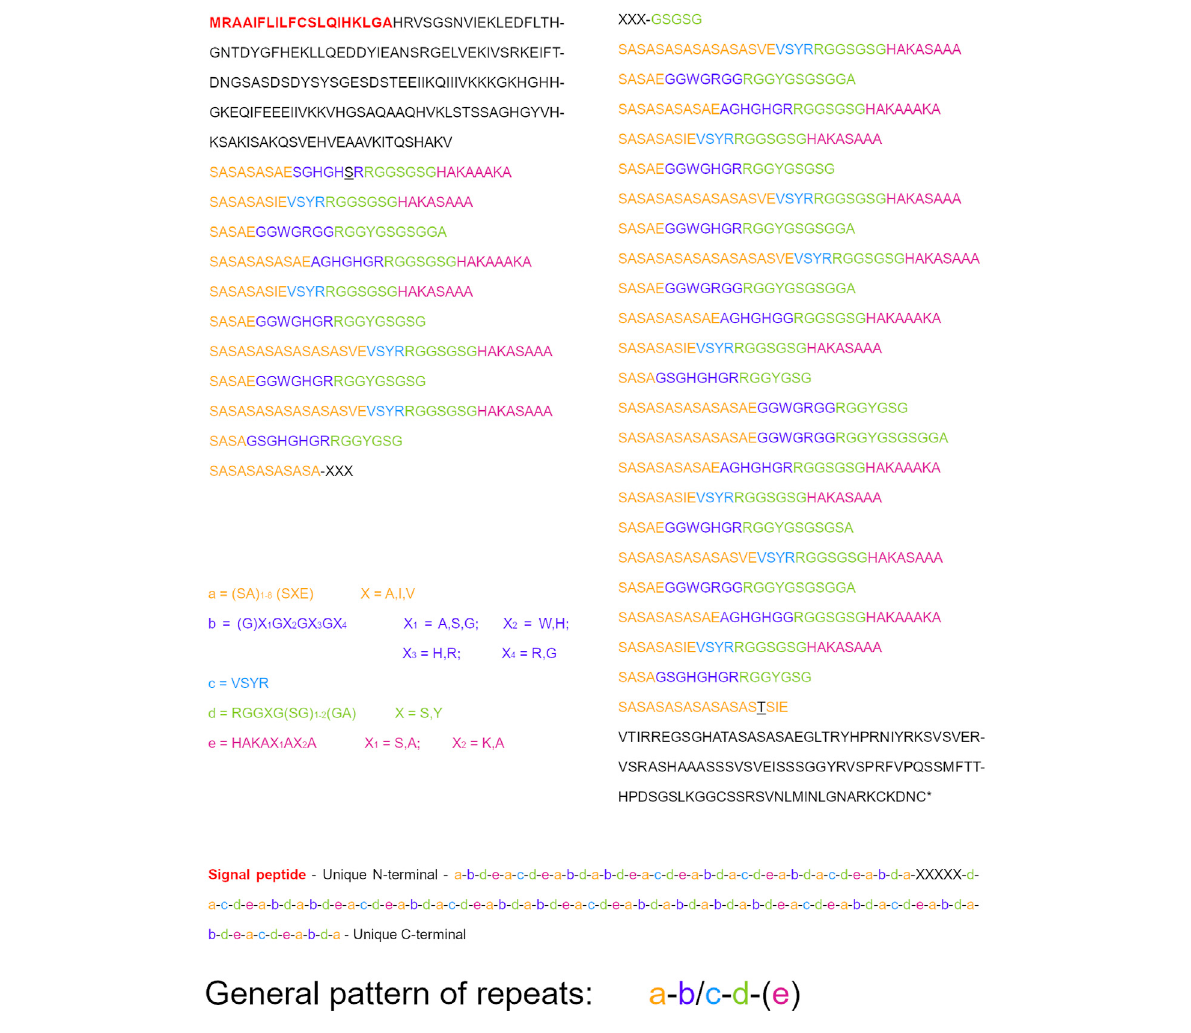
FIGURE 4 Structure of the repeats in FibH amino acid sequence. Different sections labelled by letters format: red bold — signal peptide; black — terminal unique sequence; yellow — repeat a; purple — repeat b; blue — repeat c; green — repeat d; pink — repeat e; black underlined — consensus-breaking amino acids. The sequences of the repeat sections are simpli fi ed to general formulae, where X letters stand for variable amino acids (the options for the particular Xs are always stated next to the formula). Parentheses with a numeric interval label variable number of the amino acids inside them. Parentheses without any numbers label amino acids that are not always present. The order of the individual repeat sections are summarized into a general pattern, where the mutual exclusiveness of repeat sections “ b ” and “ c ” is represented by a slash, whereas the repeat section “ e ” is in parentheses, indicating that it is not always